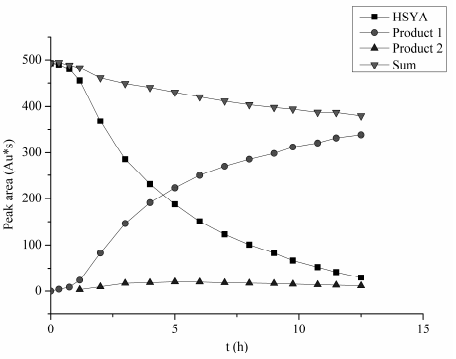
Figure 5. Mass balance of HYSA and the two degradation products at pH 9.16.